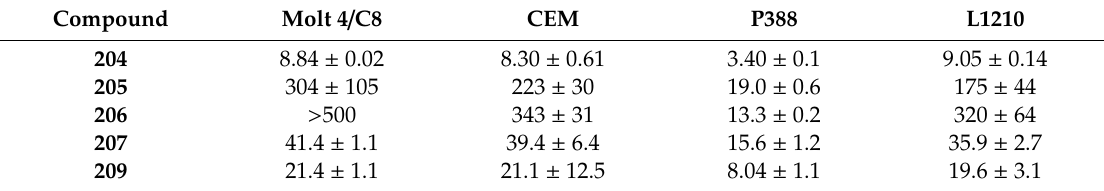
Table 30. Inhibitory e ff ect of compounds 204 – 207 and 209 against the human Molt 4 / C8, CEM T-lymphocytes, and murine P388 and L1210 leukemic cells: activity is expressed as IC 50 values in µ M.